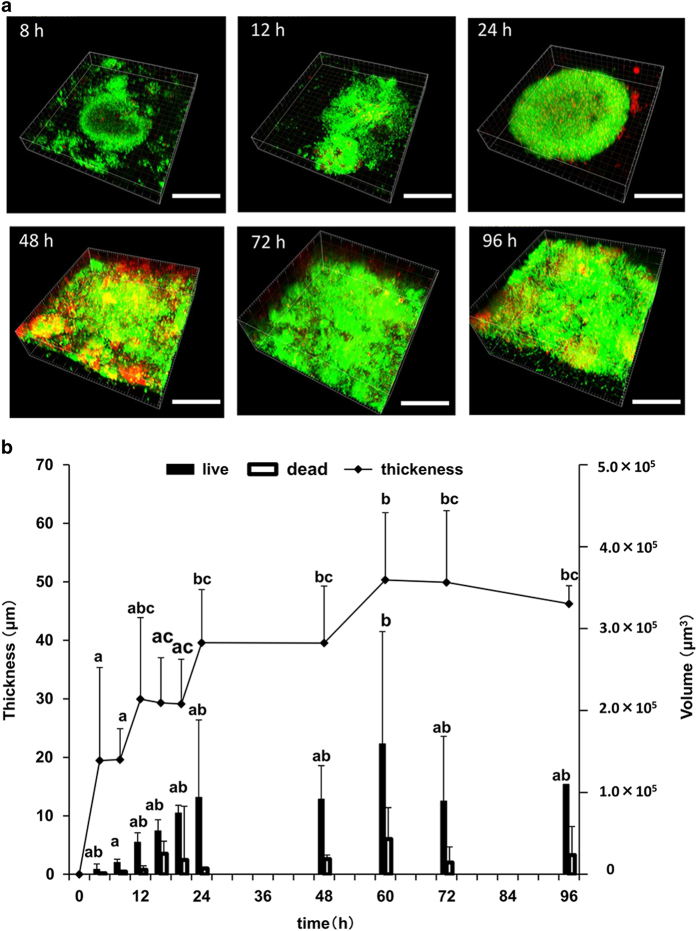
CLSM analysis of biofilms. (a) CLSM observations. Scale bar, 50 μm. (b) Determination of the thickness and volume of live and dead cells using Imaris imaging software. Black and white bars represent the volumes of live and dead cells, respectively. The letters a, b and c represent significant difference as indicated by the opposing letters (one-way analysis of variance, Tukey–Kramer test, P<0.05). There were no significant differences at any time between the volumes of dead cells. CLSM, confocal laser scanning microscope.